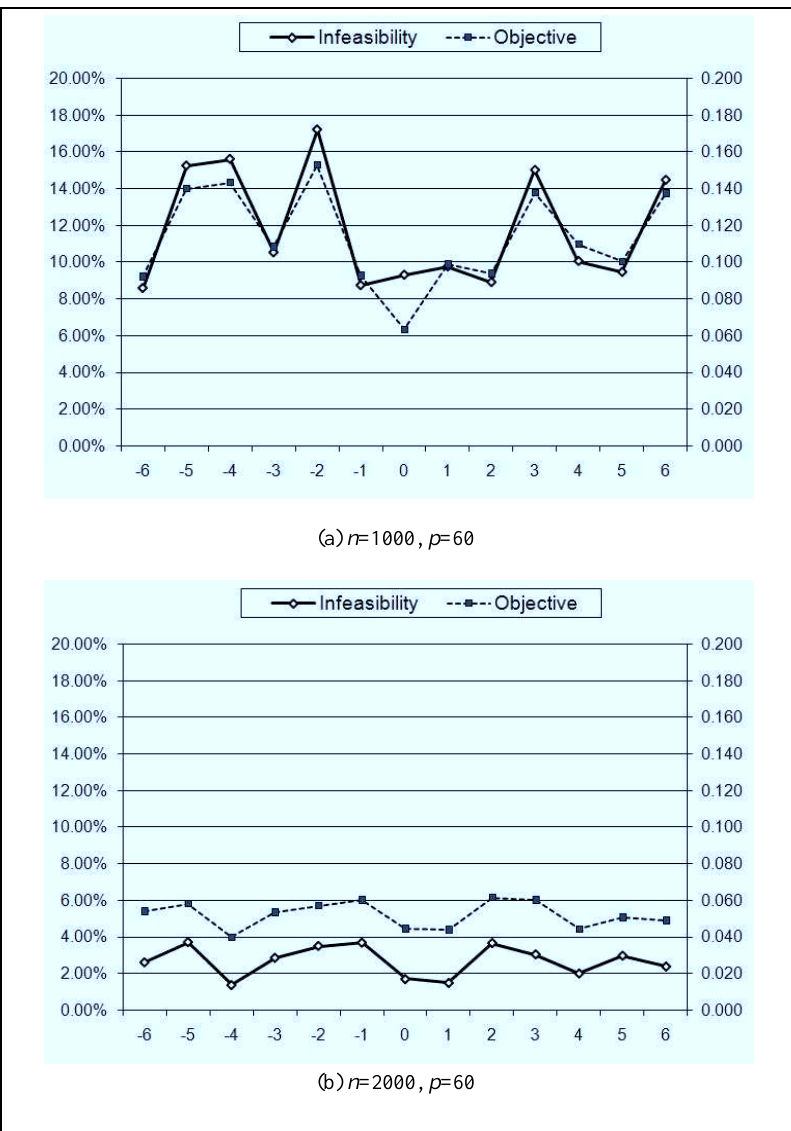
Fig. 10. Steepest descent average results for objective func- tion and infeasibility values for p =60